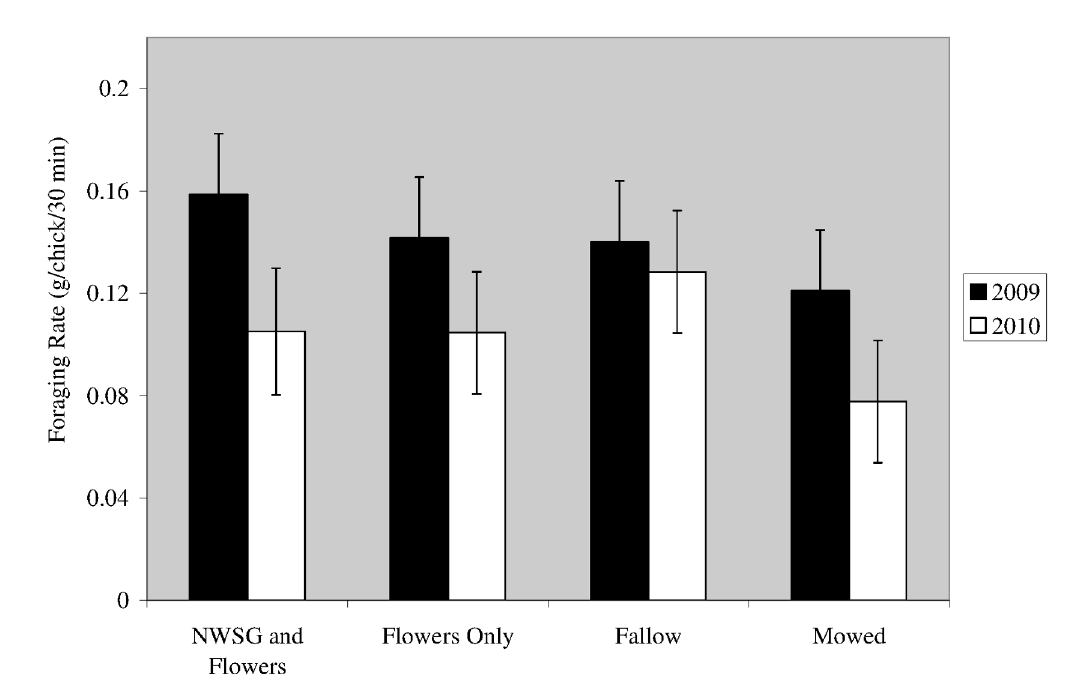
Figure 1. Estimated least-square mean (± standard error) foraging rates for northern bobwhite chicks within field border treatments. Foraging rates were collected in North Carolina in 2009 and 2010. Foraging rates are reported as g of arthropods consumed/chick/30 min. Least-square mean estimates and SE were derived from MIXED models. doi: